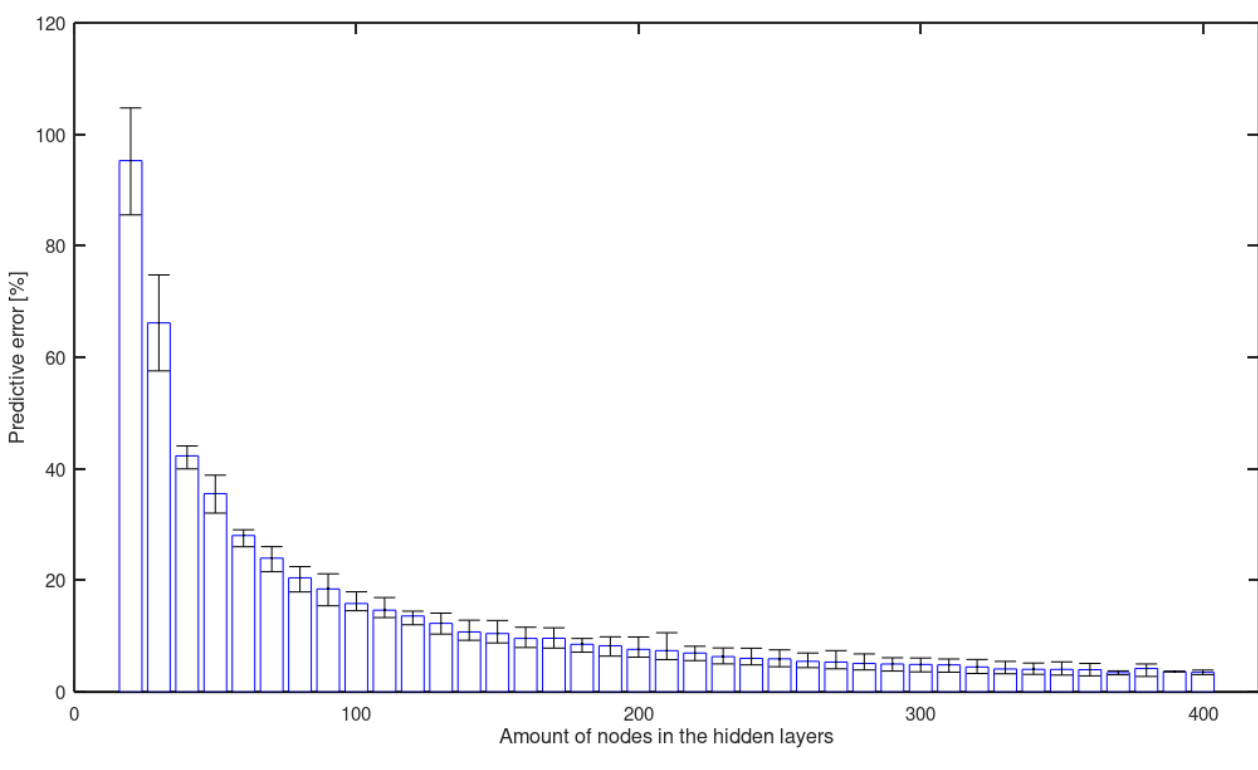
Figure 4. Predictive error [%] as a function of the amount of nodes in both hidden